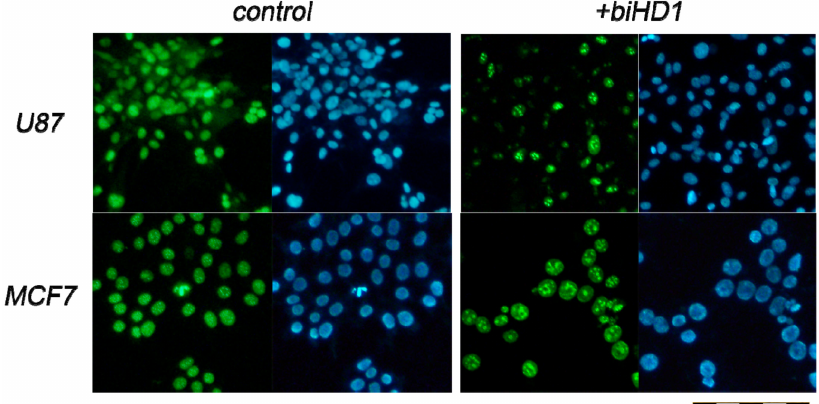
Figure 3. Fluorescence images of U87 cells (up) and MCF7 cells (bottom) incubated with 10 µ M biHD1 (right panel), and with no oligonucleotide added (control left panel) for 72 h. Proliferating cells were stained with fluorescent Ki-67-antibody, green images; all cells were stained with bisbenzimide nuclear fluorescent dye, blue images. Scale bar for all images = 100 µ